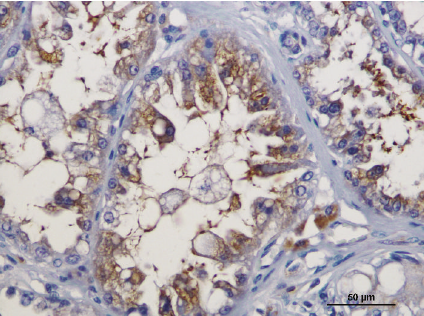
Figure 1: Immunoreactivity for c-kit in tubulopapillary carcinoma; note the simultaneous cytoplasmic and membranous staining; bar = 50 𝜇 m.